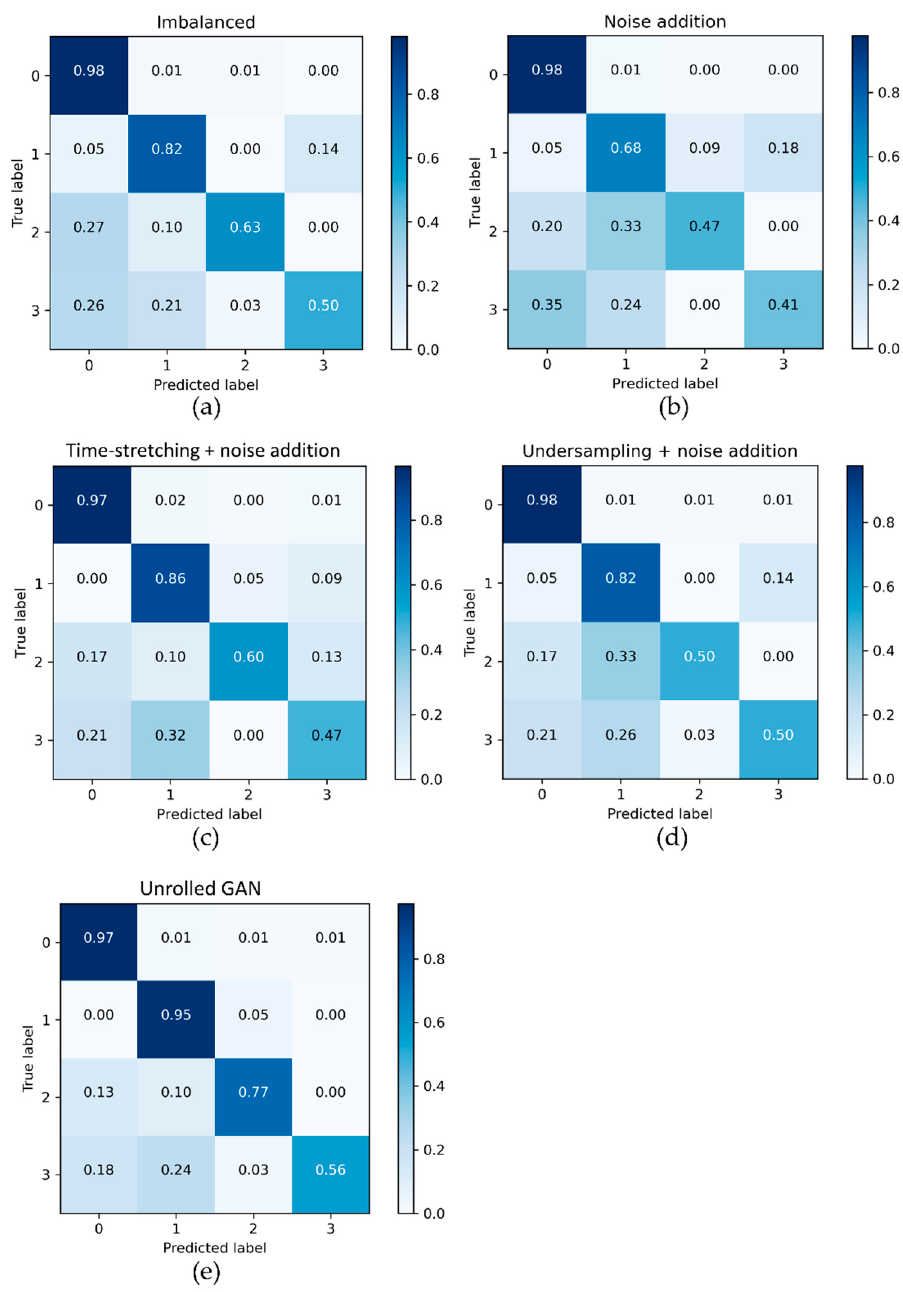
Figure 16. Classification performance of the base classifier trained on: ( a ) unbalanced data, ( b ) noise addition augmented data, ( c ) time-stretching + noise addition augmented data, ( d ) undersampling + noise addition, and ( e ) the augmented data of the case